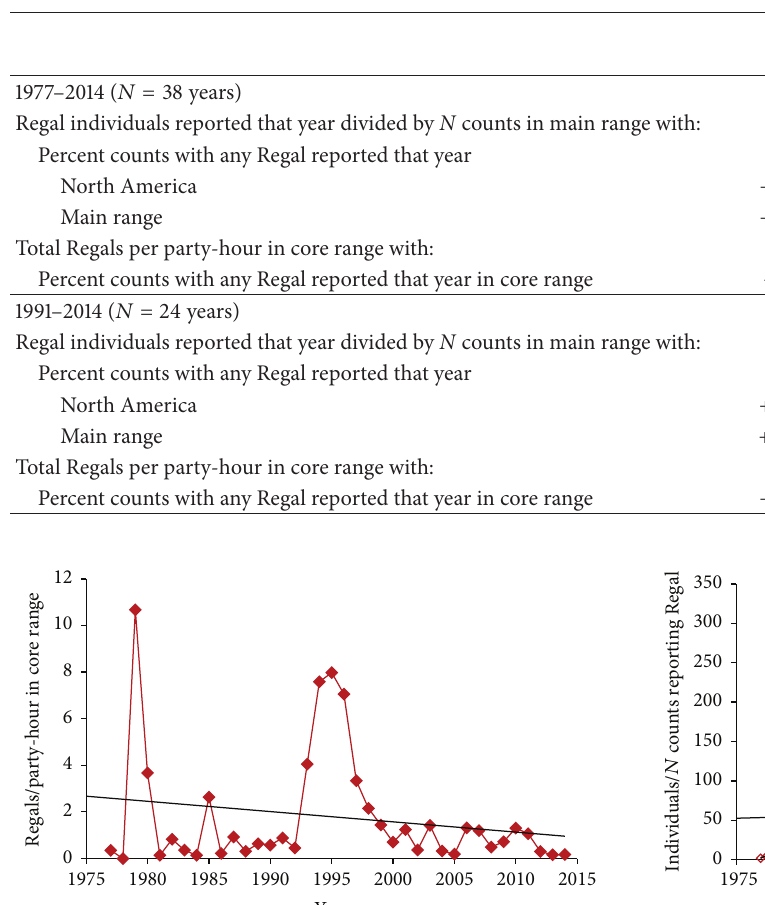
Table 5: Results of Pearson product moment and Spearman rank correlations of a Regal Fritillary abundance variable to presence-absence (percent) variables. NS = not significant.